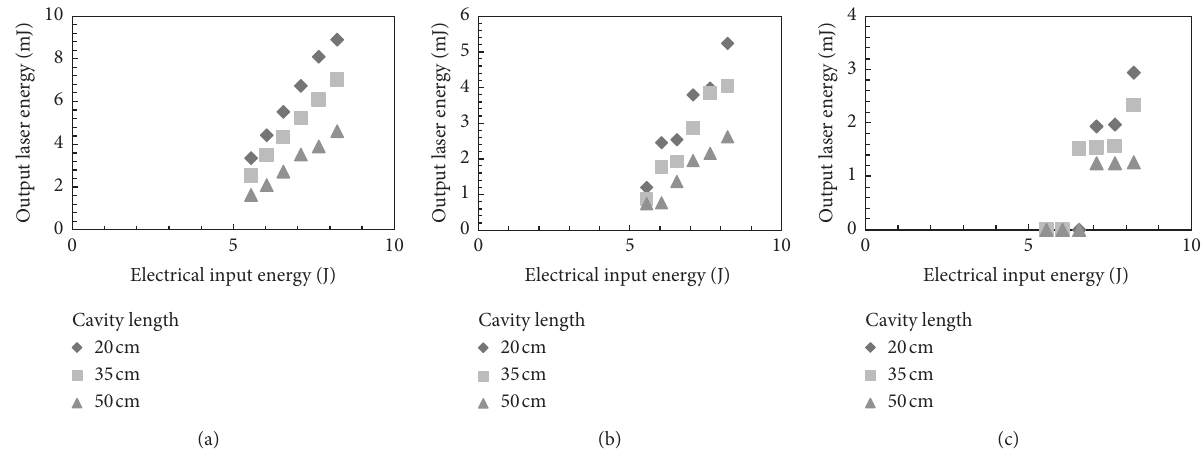
Figure 4: Output laser energy (SESAM R � 97%): (a) Cr 4+ :YAG T � 90%; (b) Cr 4+ :YAG T � 80%; (c) Cr 4+ :YAG T � 70%.